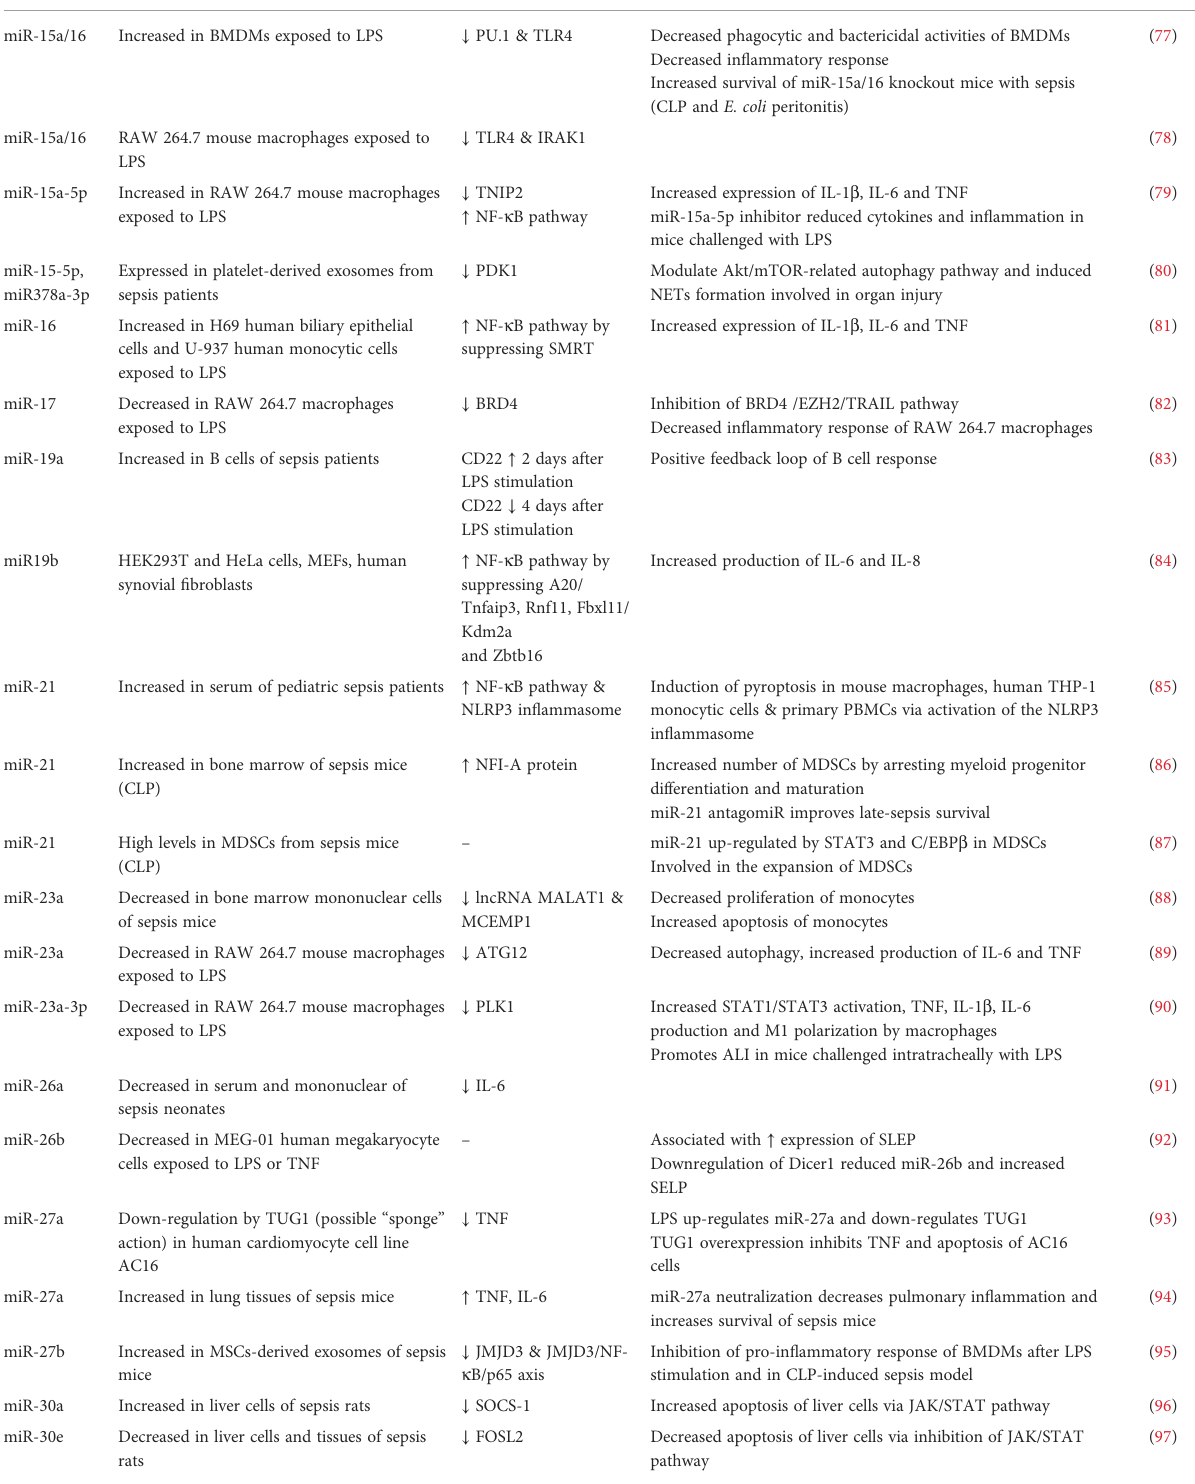
TABLE 1 Selection of miRNAs related to sepsis.